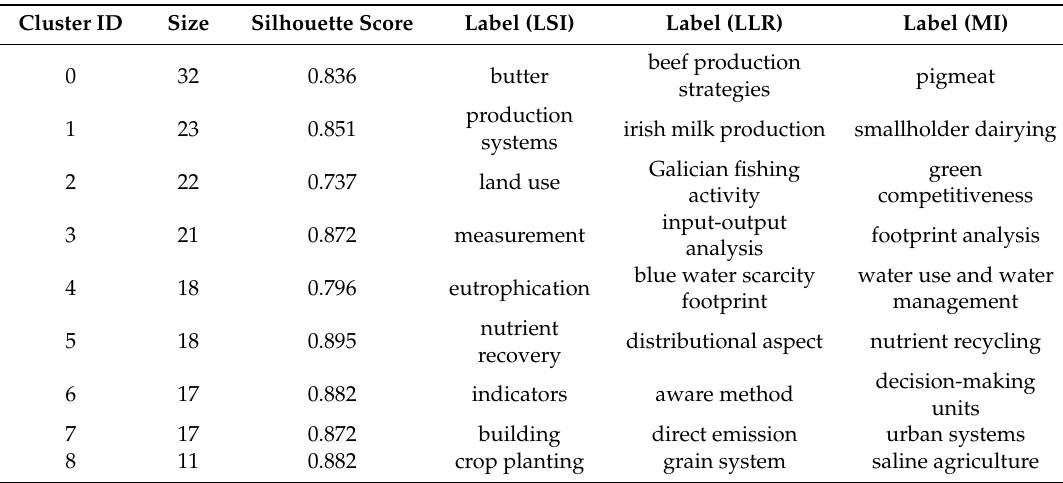
Table 3. Major clusters of co-citation references.